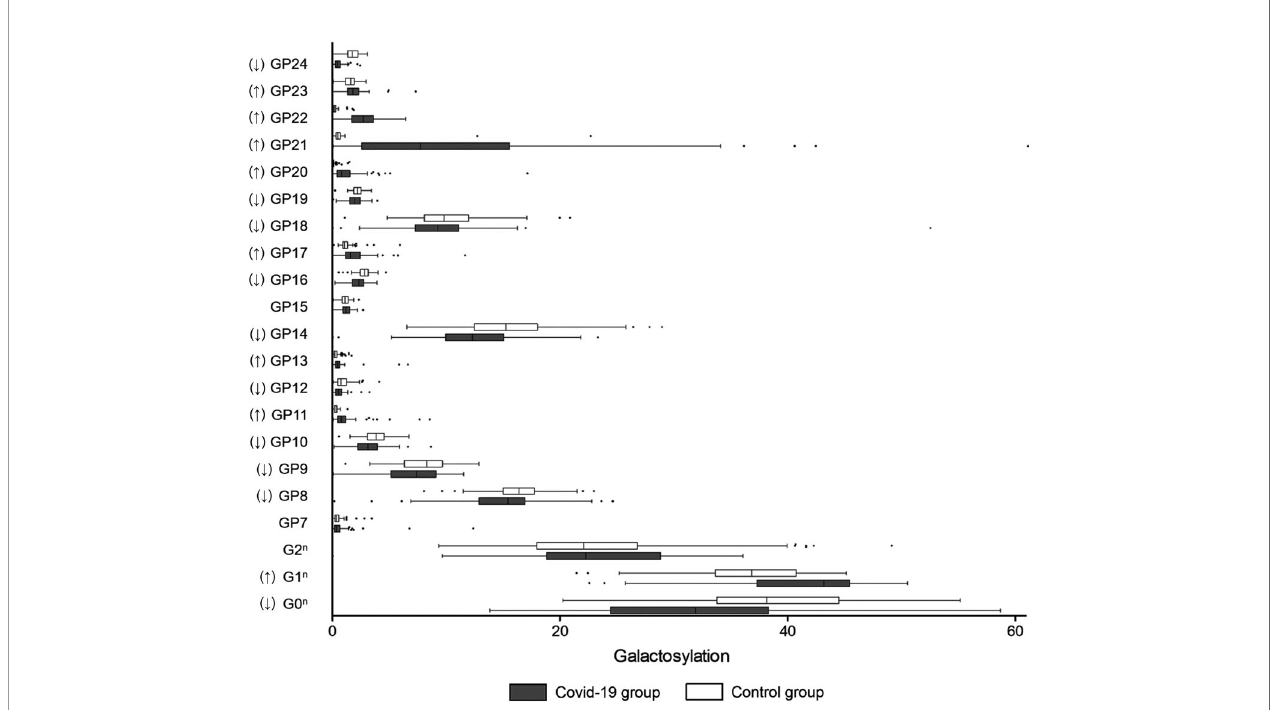
FIGURE 4 | Galactosylation on IgG in COVID-19 patients and the healthy controls. B, bisecting N-acetylglucosamine (GlcNAc); F, fucose; G, galactose; GP, glycan peak; S, Sialic acid; ↑ , the glycan in COVID-19 group is signi fi cantly higher than that in the controls; ↓ , the glycan in COVID-19 group is signi fi cantly lower than that in the